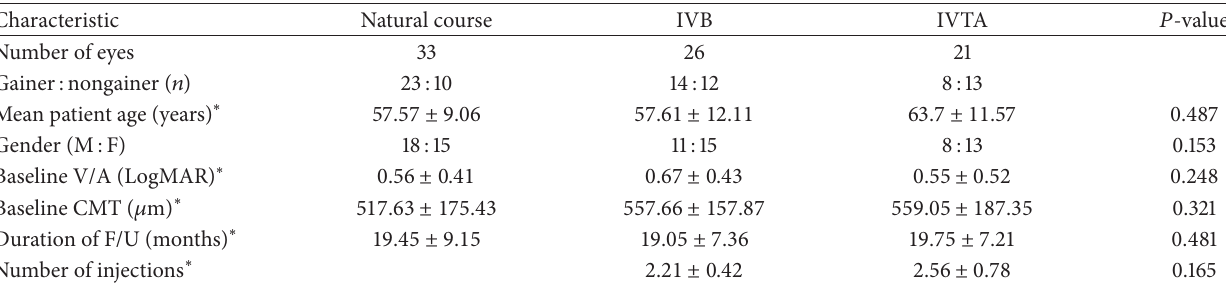
Table 3: Demographic data for each group.